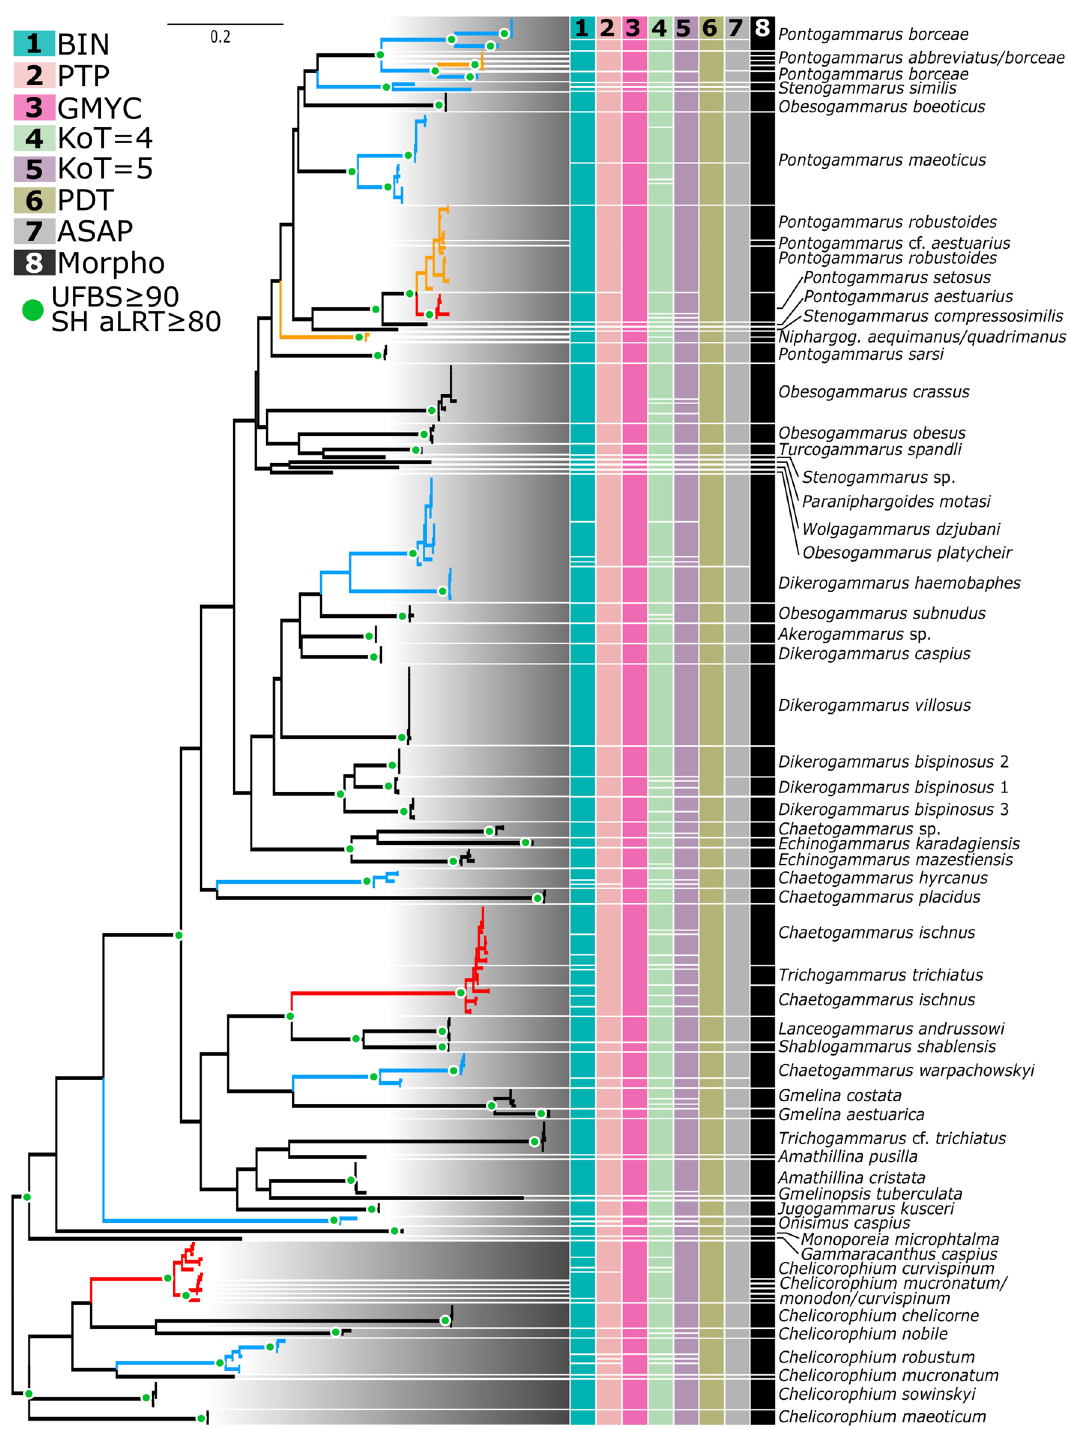
Figure 2. Maximum-likelihood COI tree and species delimitation results. Green dots at nodes indicate strongly supported clades (UFBS – ultrafast bootstrap support; SH aLRT – Shimodaira-Hasegawa approximate likelihood ratio test). The results of the species delimitation analyses are shown by the coloured columns to the right. Each colour represents a different method/parameter setting. Blue branches represent morphospecies which have been split into multiple MOTUs by at least half of the methods. Orange branches indicate morphospecies that have been lumped into one MOTU by at least half of the methods. Red branches indicate morphospecies that were both lumped and split by at least half of the methods. The fully annotated tree is provided in the supplementary Fig.